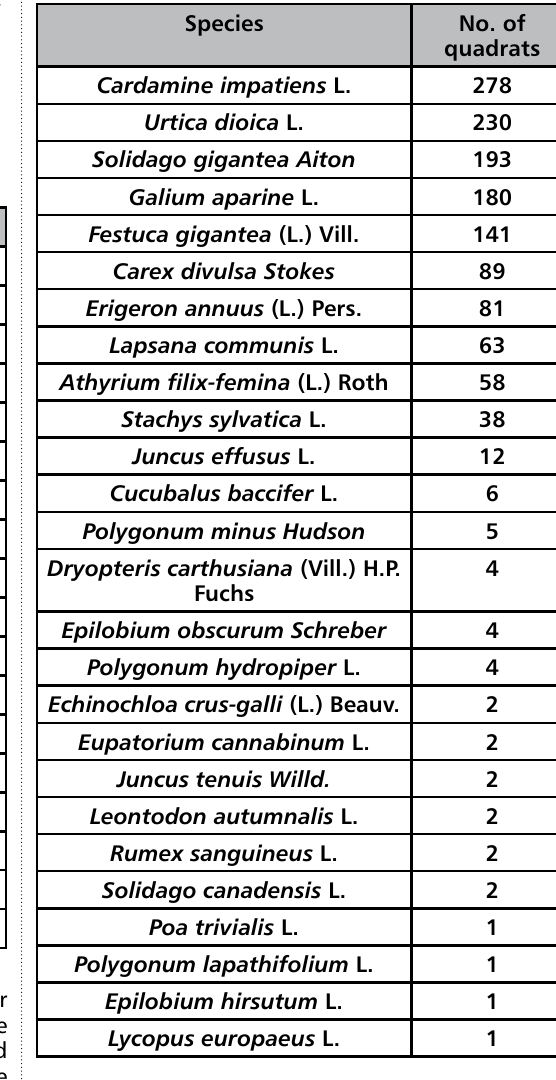
Soil moisture indicator herbaceous species occurred in the gaps. No. of quadrats – number of those 1 x 1 m quadrats in which the given species